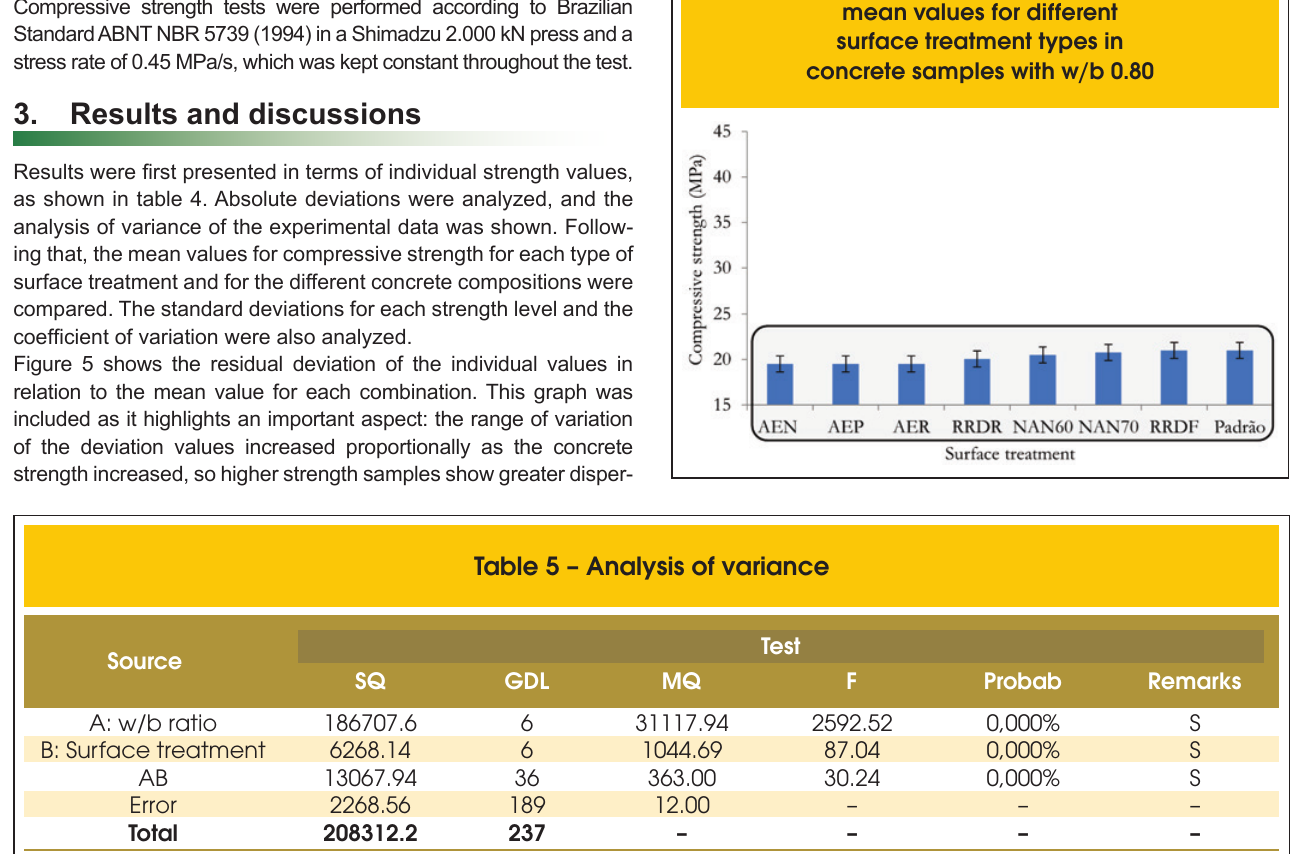
Figure 6 – Comparison of the mean values for different surface treatment types in concrete samples with w/b